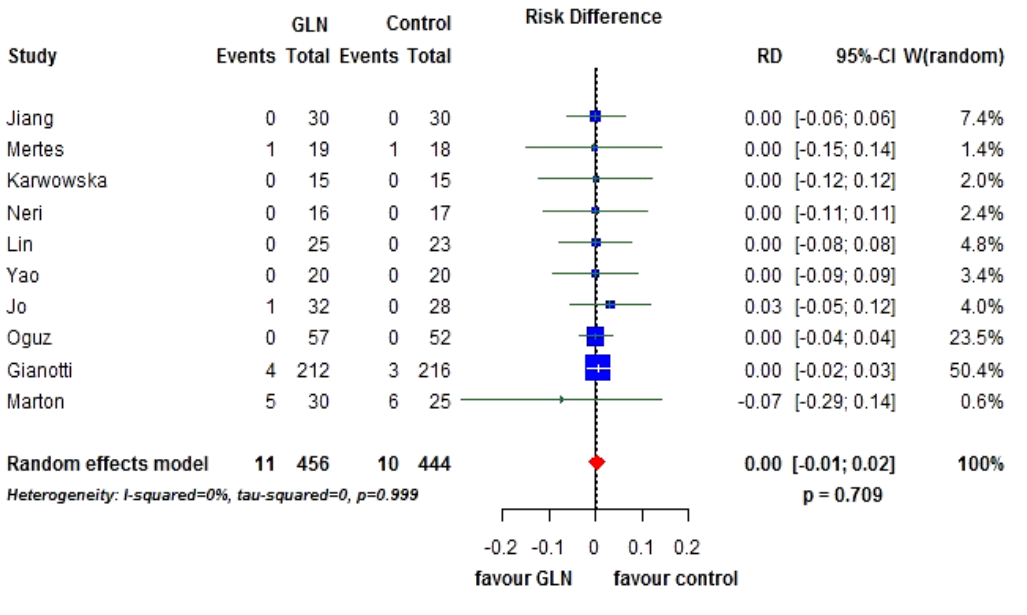
Figure 2. Forest plot for overall mortality comparing glutamine (GLN) vs. control. GLN: glutamine, RR: relative risk, CI: confidence